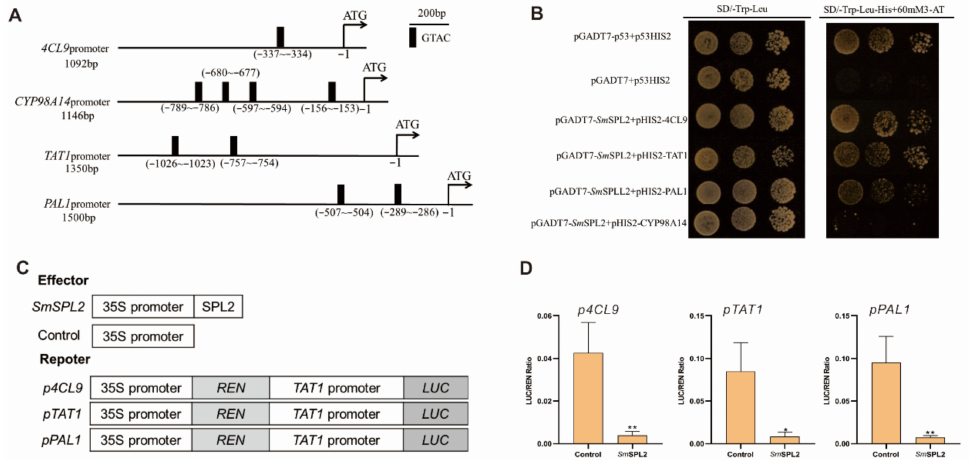
Figure 6. Sm SPL2 binds to the promoter regions of Sm4CL9 , SmTAT1 , and SmPAL1 and inhibits their expression. ( A ) GTAC motifs in the promoter regions of Sm4CL9 , SmCYP98A14 , SmTAT1 , and SmPAL1 . Black rectangles represent the GTAC motif. ( B ) Yeast one-hybrid detected interactions between the Sm SPL6 and the promoters of Sm4CL9 , SmCYP98A14 , SmTAT1 , and SmPAL1 . The p53HIS2/pGADT7-p53 and p53HIS2/pGADT7 were the positive and negative controls, respectively. ( C ) Schematic diagram of constructs used in assays of transient transcriptional activity. ( D ) Sm SPL2 inhibited the expression of Sm4CL9 , SmTAT1 , and SmPAL1 . Effector Sm SPL2 was co-transformed with reporter p4CL9 -LUC, pTAT1 -LUC, or pPAL1 -LUC. All data are mean values of three biological replicates, with the error bar representing SD. * and ** indicate significant differences from the control at p < 0.05 and p < 0.01 levels, respectively, by Student’s t